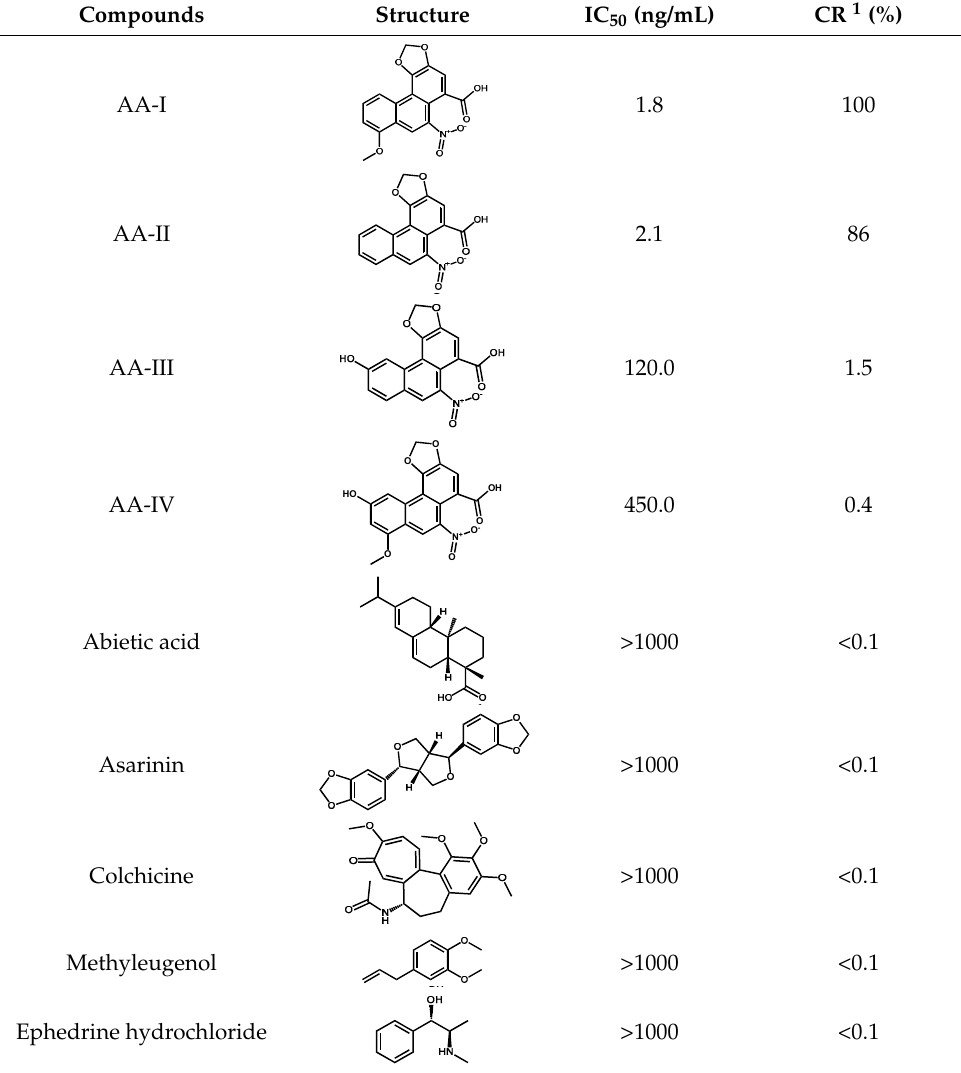
Figure 2. ( A ) The calibration curve; ( B ) the linear range of CLEIA. Table 2. The specific test of anti-AA-I mAb.